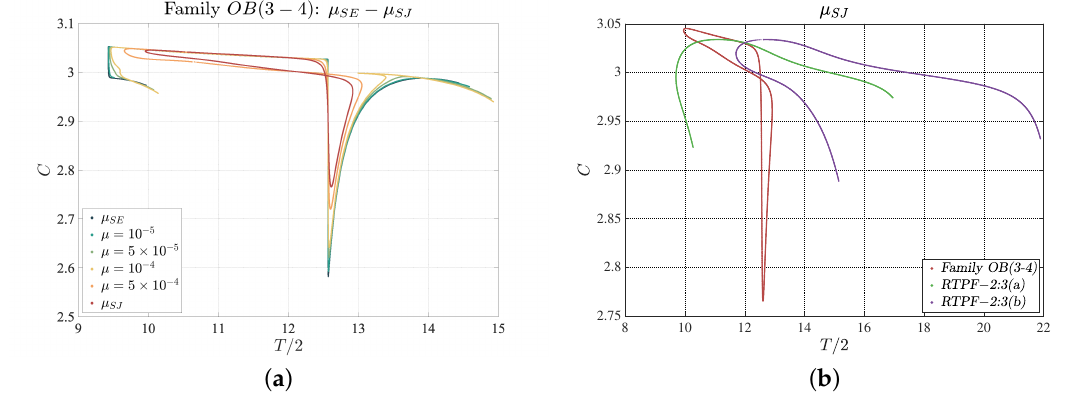
Figure 10. ( a ) Characteristic curves of the family OB ( 3 − 4 ) continued from the Sun–Earth system ( µ SE ) to the Sun–Jupiter system ( µ SJ ). Different colors indicate different mass parameters. ( b ) Charac- teristic curves of the family OB ( 3 − 4 ) and two RTPFs in the system with µ SJ . T /2 is half the orbital period in the synodic frame. C is the Jacobi constant. x 0 is the initial state of the periodic orbits on the x